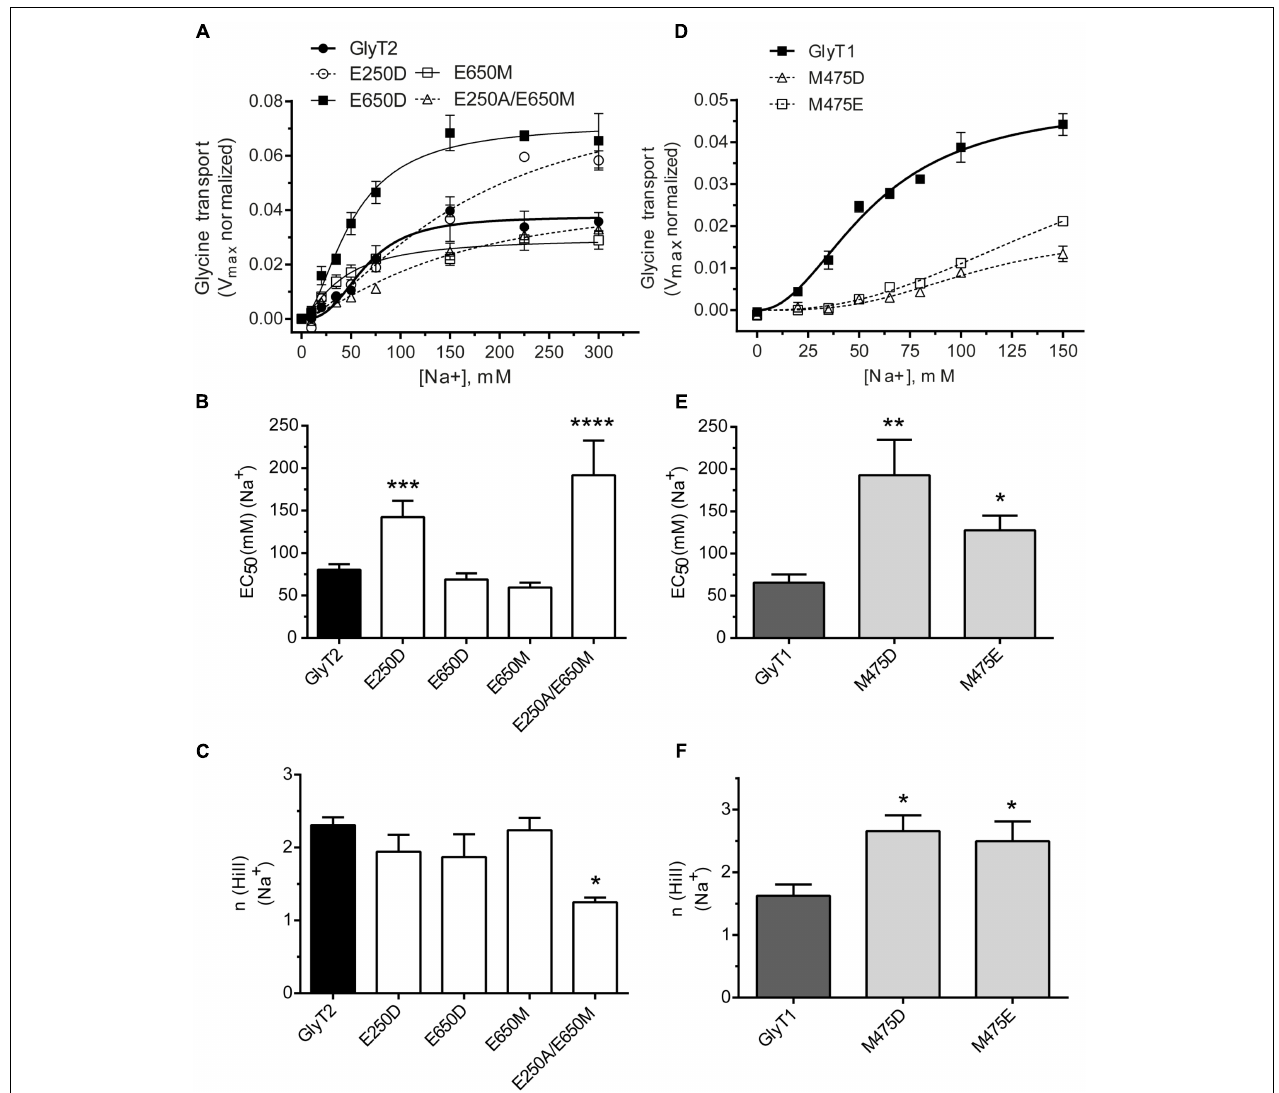
FIGURE 3 | Sodium dependence of glycine transport by GlyT2 and GlyT1 substitution mutants. COS7 cells expressing the indicated transporters were assayed for glycine transport in the presence of increasing extracellular NaCl concentrations (isotonic substitution by choline chloride). Control glycine transport by wild type GlyT2 and GlyT1 were 2.0 ± 0.06 and 5.49 ± 0.26 nmol glycine/mg protein/10 min, respectively. (A,D) Representative experiments are shown that were repeated at least three times performed in triplicate. Glycine transport has been V max normalized. Experimental data were fitted to the Hill equation. (B–F) EC 50 for sodium